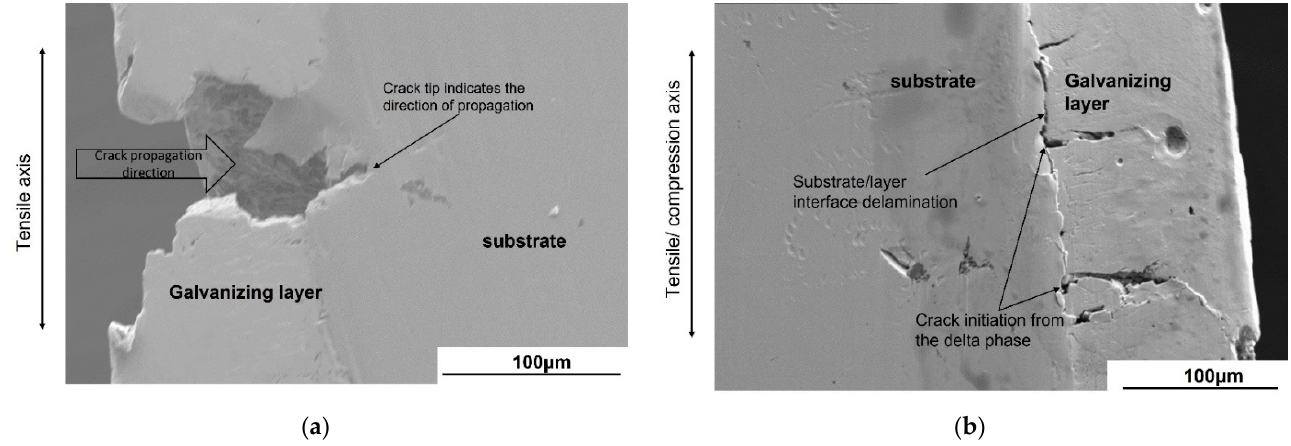
Figure 13. SEM images of the subcracks at the galvanizing layer/substrate interface: ( a ) Subcracks grow from the surface to the substrate at R = 0.01, and ( b ) delamination and subcracks originating from the delta phase at R = − 1.0.